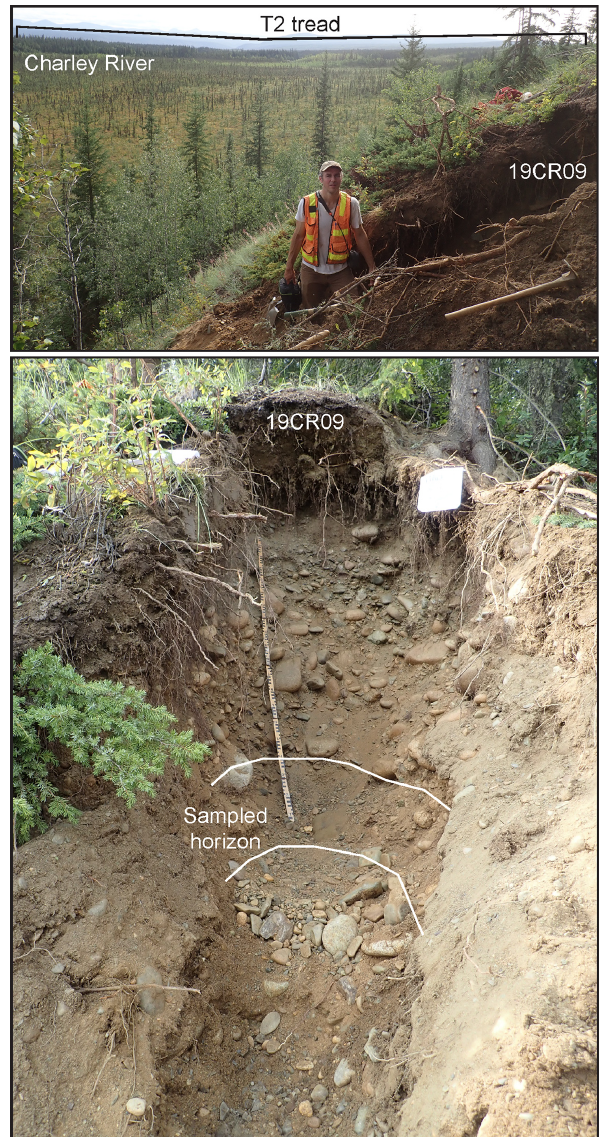
Figure A4. Cosmogenic isochron burial age sample site 19CR09. Site located on the Charley River intermediate terrace (T2) in Alaska near the Charley–Yukon River confluence. Top photo is taken looking upstream (south), person is standing in sample pit, the Charley River flows between the broad floodplain in the foreground (bright green) and T2 in the background (dark green). Photographs by the US Geological